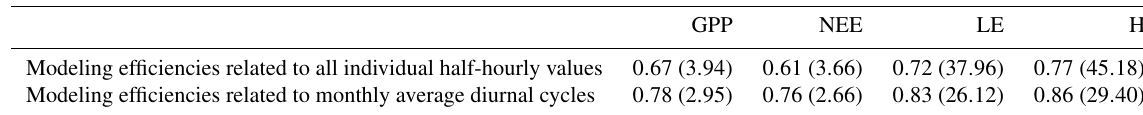
Table 3. Prediction performances in terms of modeling efficiency (and RMSE in µmolm − 2 s − 1 ) are estimated from the leave-one-site-out cross-validation experiments with the setup that has been used to compute the global half-hourly products for the four fluxes. GPP NEE LE H Modeling efficiencies related to all individual half-hourly values 0 . 67 (3 . 94) Modeling efficiencies related to monthly average diurnal